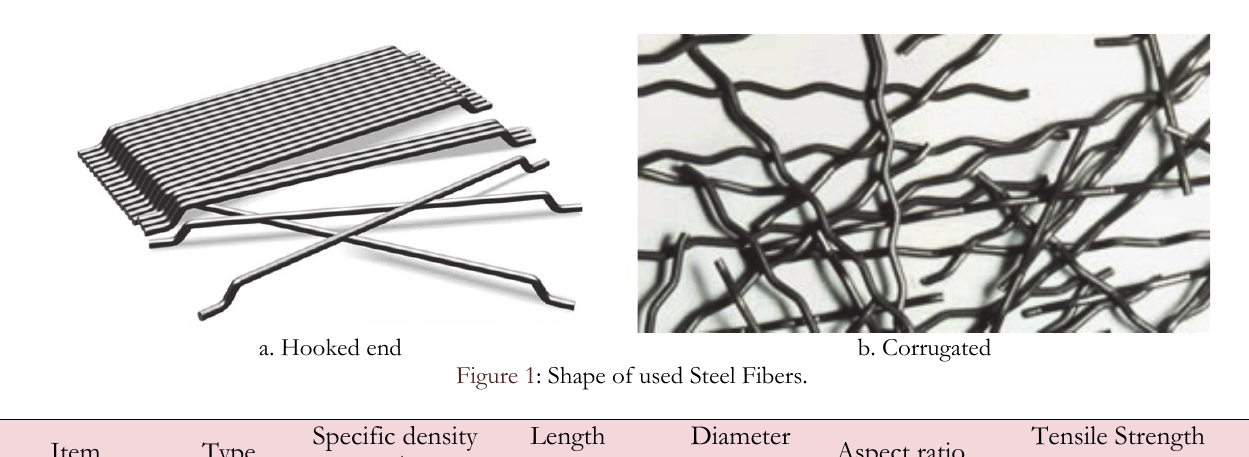
Table 1: OPC, SF, and FA Chemical and physical properties. S.D= Specific density (kg/m 3 ).